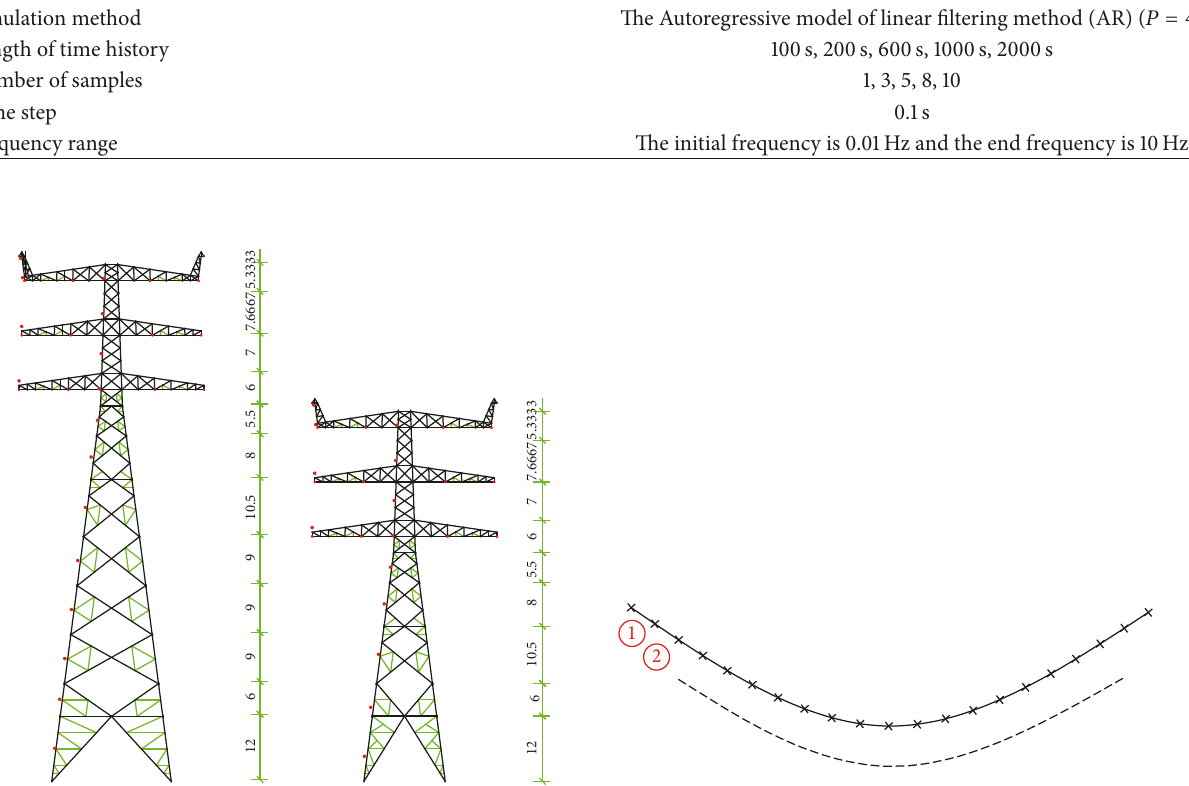
Figure 3: Subsection schematic of single towers and